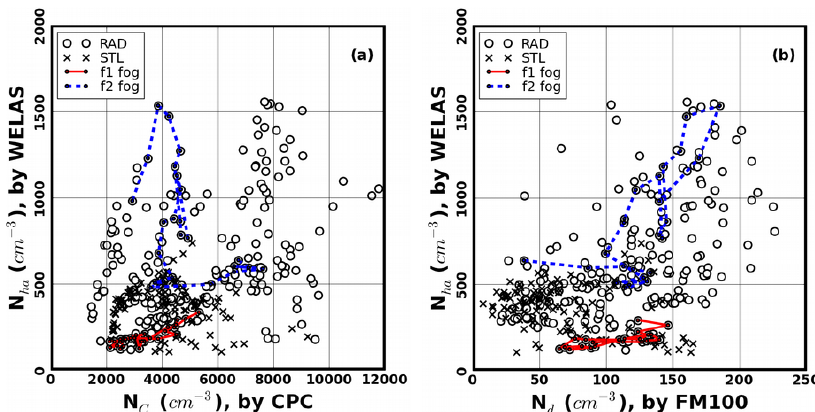
Figure 11. The relationships between several particle number concentrations, marked according to the main formation process, in RAD and STL fogs of November 2011 at SIRTA: (a) the hydrated aerosol number concentration ( N ha ) in function of all aerosol number concentration ( N C ) ; (b) N ha in function of the droplet number concentration ( N d ) . Two RAD fog events are highlighted in red and